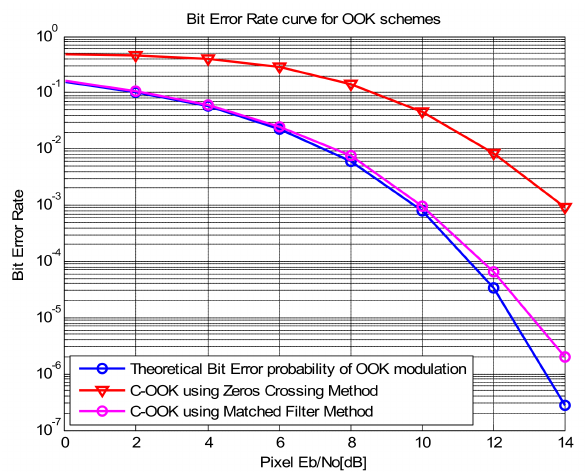
Figure 11. Comparison of bit error rate (BER) of the C-OOK scheme using a matched filter and zero-crossing techniques with the theoretical Bit Error probability of OOK